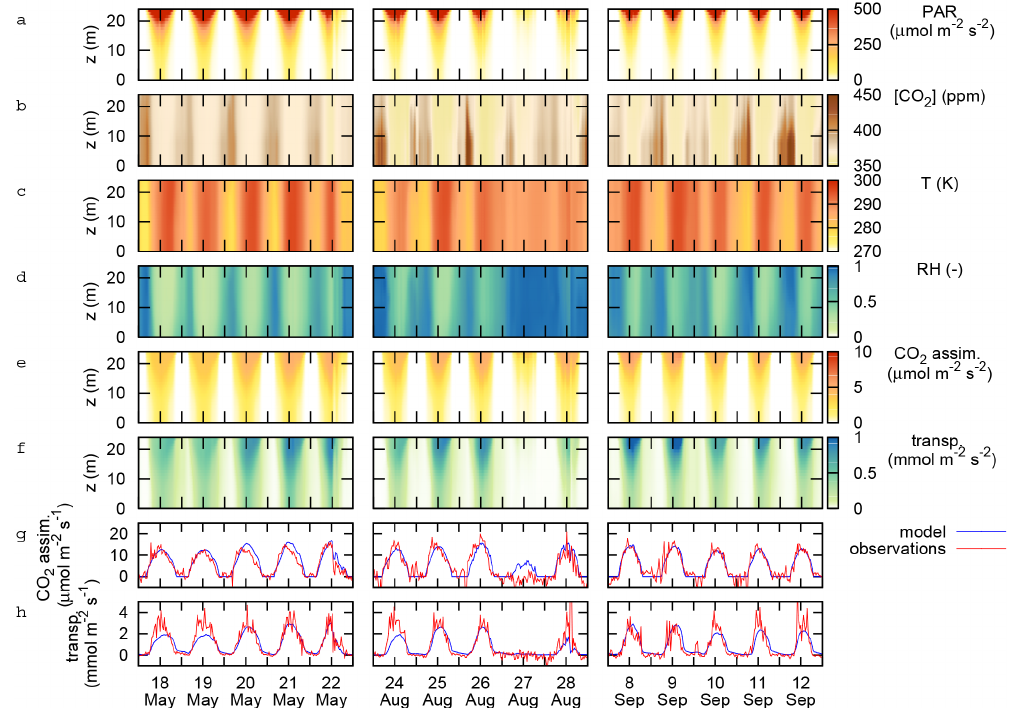
Figure 4. Overview of vertical gradients in the canopy for three periods: 18–22 May 1999 (case 1), 24–28 August 1999 (case 2) and 8–12 September 1999 (case 3). Shown are gradients of (a) leaf-level absorbed photosynthetically active radiation (PAR), averaged per canopy layer, (b) atmospheric CO 2 concentration, (c) air temperature, (d) relative humidity, (e) simulated CO 2 assimilation and (f) simulated transpiration, as well as the canopy-integrated (g) CO 2 assimilation and (h) transpiration, compared with observed fluxes (the canopy-integrated fluxes in (g) and (h) are expressed per ground area). The gradient in PAR originates from detailed simulation of the light transfer in the canopy. Gradients in CO 2 , air temperature and relative humidity were obtained from linear interpolation of measurements at 5–6 levels in and directly above the